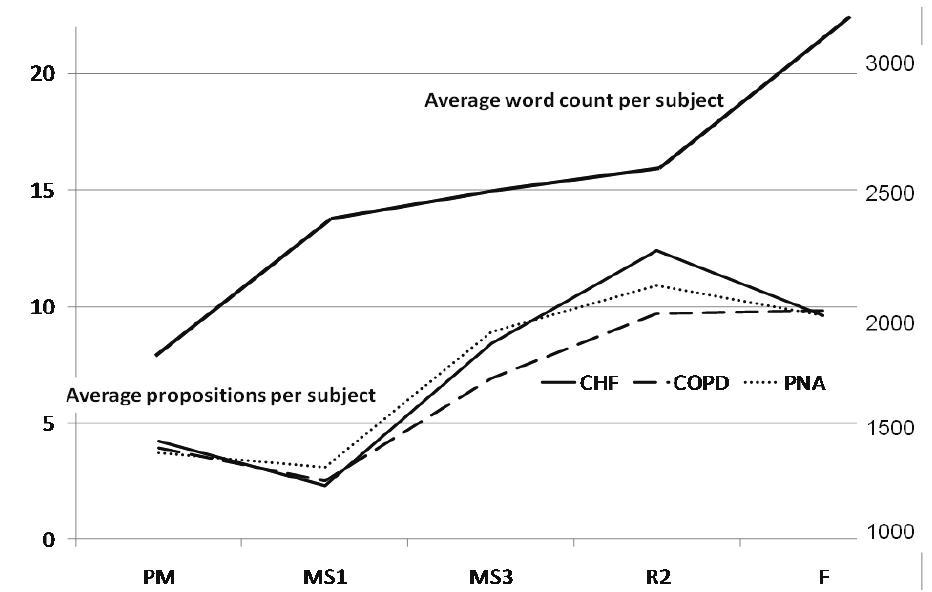
Figure 1. Average word count and propositions per